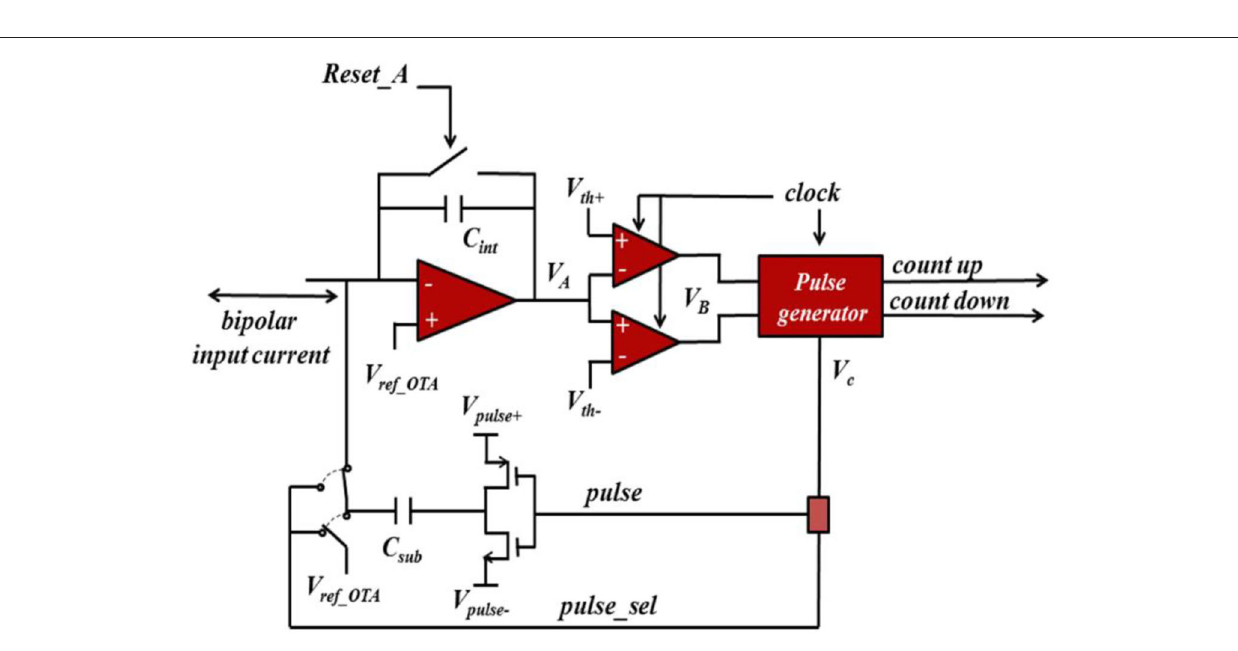
FIGURE 3 | Example of recycling integrator functional blocks